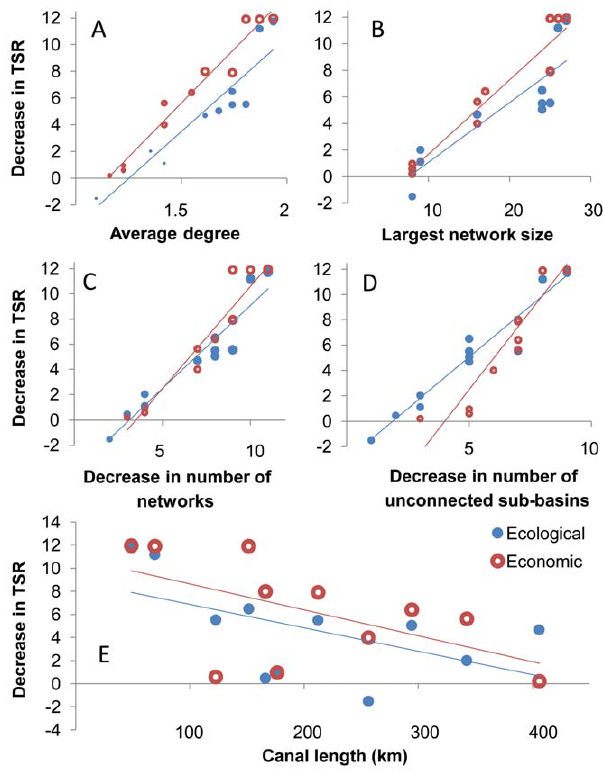
Figure 3. System connectivity underlies the loss of species (TSR, total species richness) for both the economic (open red circles) and the ecological (closed blue circles) linking strate- gies. This relationship holds for different measures of connectivity. Average degree (panel A; size of circles relative to the average number of connected sub-basins of the peninsular river networks, which increase as unconnected rivers are linked via canals), largest network size (panel B; size of circles relative to the average degree), decrease in the number of river networks (panel C; size of circles relative to the average degree), and number of networks consisting of a single sub- basin (panel D; size of circles relative to the average degree).